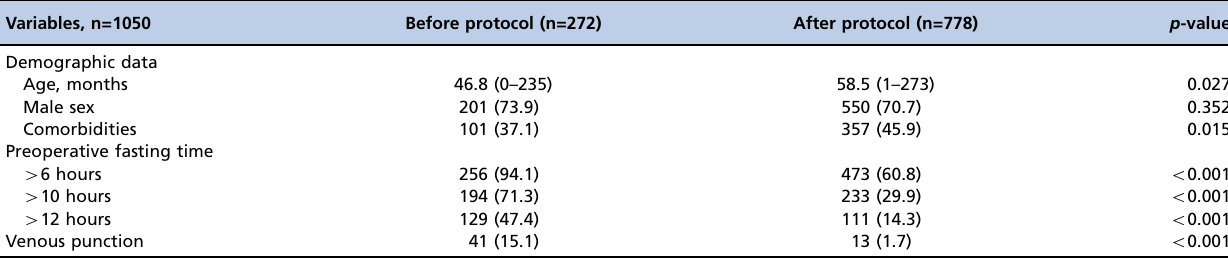
Table 2 - Demographic data, preoperative fasting time, and the need for a venous line before elective surgery for Pediatric Day Hospital Unit patients. Variables, n=1050 Before protocol